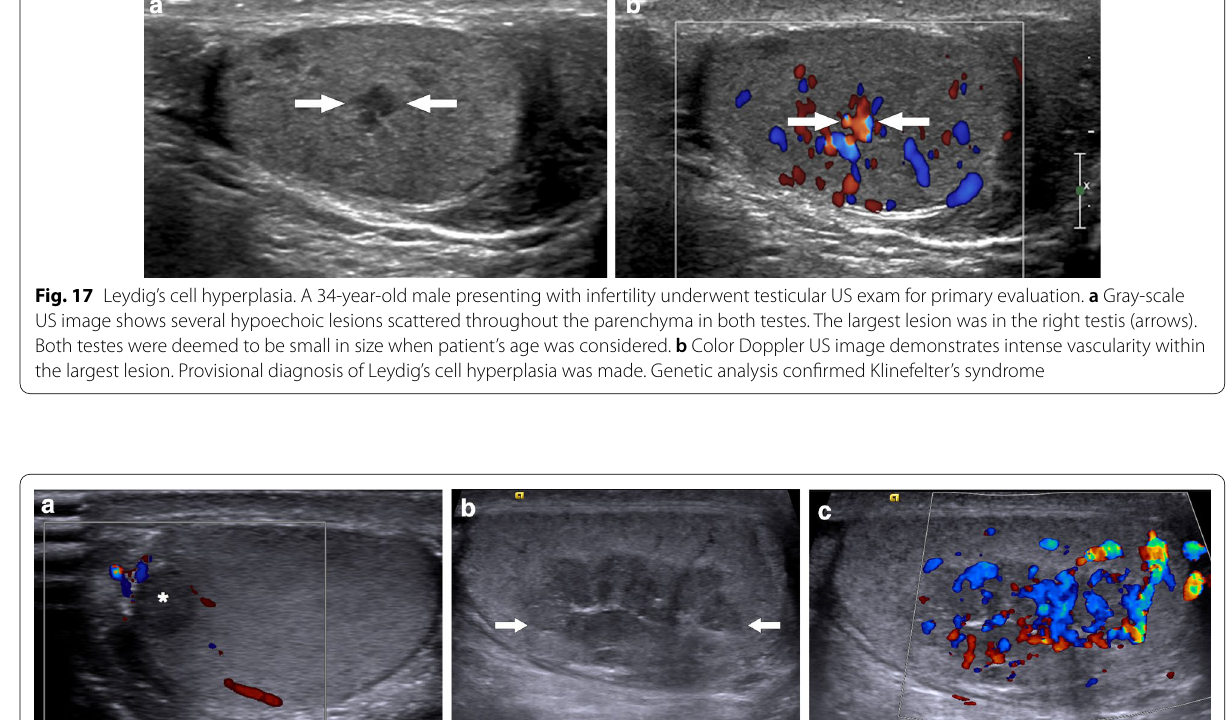
Cystic dysplasia of rete testis